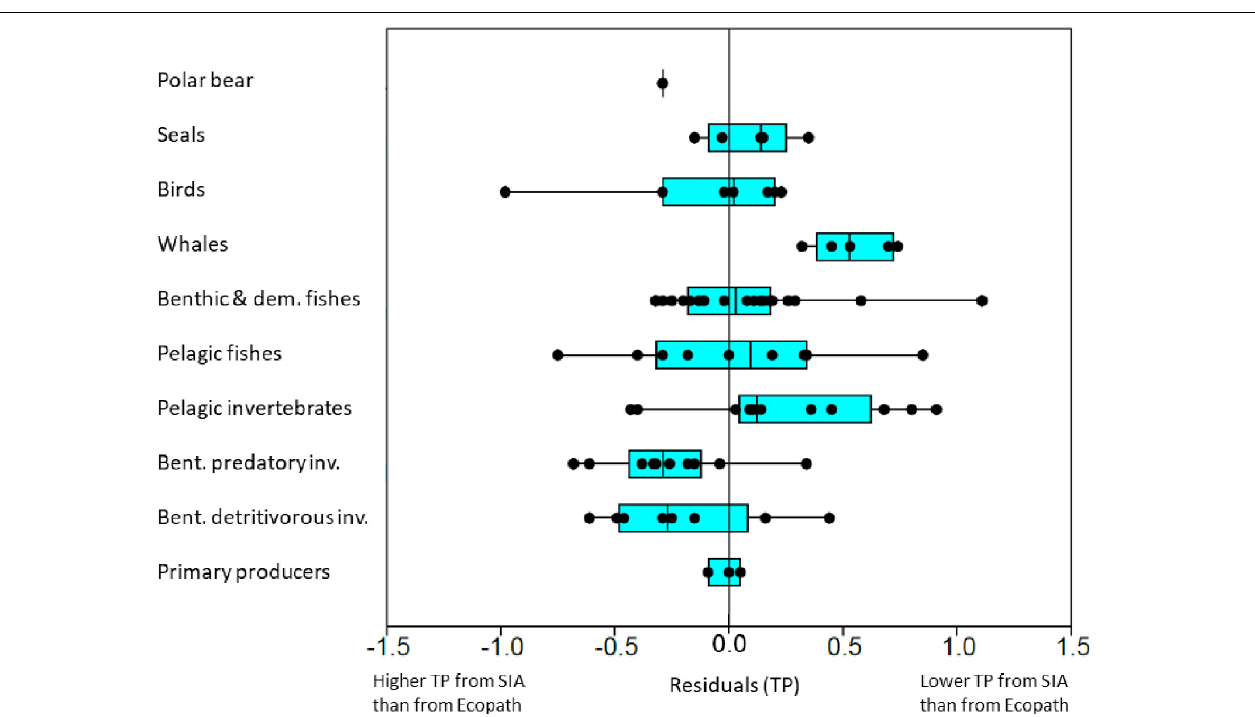
FIGURE 5 | Box-plot of residuals for trophic position values from Ecopath for functional groups predicted by the linear best-fit model for trophic position from δ 15 N values. The functional groups were grouped into major categories. The linear best-fit relationship had a δ 15 N base value of 4.4 residuals for individual FGs within each major category. Vertical line in boxes show median and boxes show 25–75% quartiles and whiskers show minimal and maximal